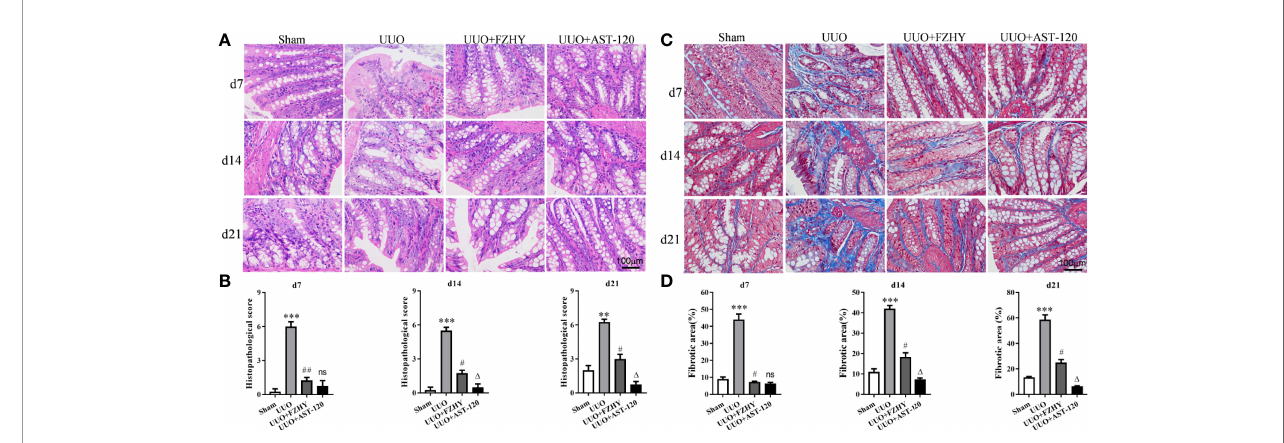
FIGURE 2 | Effect of FZHY on colon tissue in UUO rats. The colon tissue injury was assessed (A) and scored (B) based on HE staining. The colon tissue fi brosis was assessed (C) and scored (D) based on Masson ’ s trichrome staining; ×400 magni fi cation on days 7, 14, and 21. ** P < 0.01, *** P < 0.001, the UUO group vs. the sham group; # P < 0.05, ## P < 0.01, the UUO+FZHY group vs. the UUO group; D P < 0.05, the UUO+AST-120 group vs. the FZHY-treated group. ns, not signi fi cant.